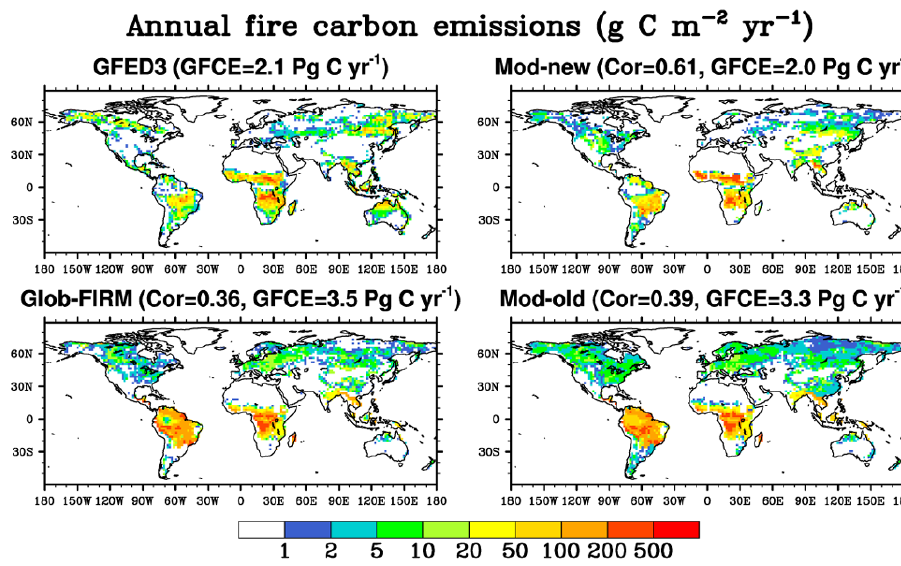
Fig. 13. Same as Fig. 8, but for annual fire carbon emissions. Besides global spatial correlation (Cor) between GFED3 and simulations, the GFED3 and simulated 1997–2004 mean annual global fire carbon emissions (GFCE) are also given.